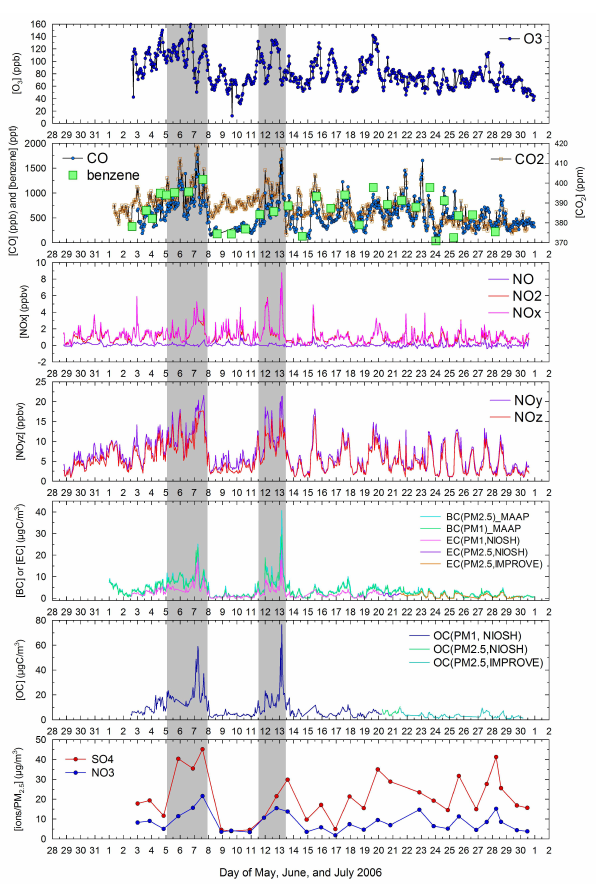
Fig. 3. Overall time series of O 3 , CO, benzene, CO 2 , NO, NO 2 , NO x , NO y , NO z , BC, OC, sulfate, and nitrate. Hatched areas indi- cate two episodes with strong influences from